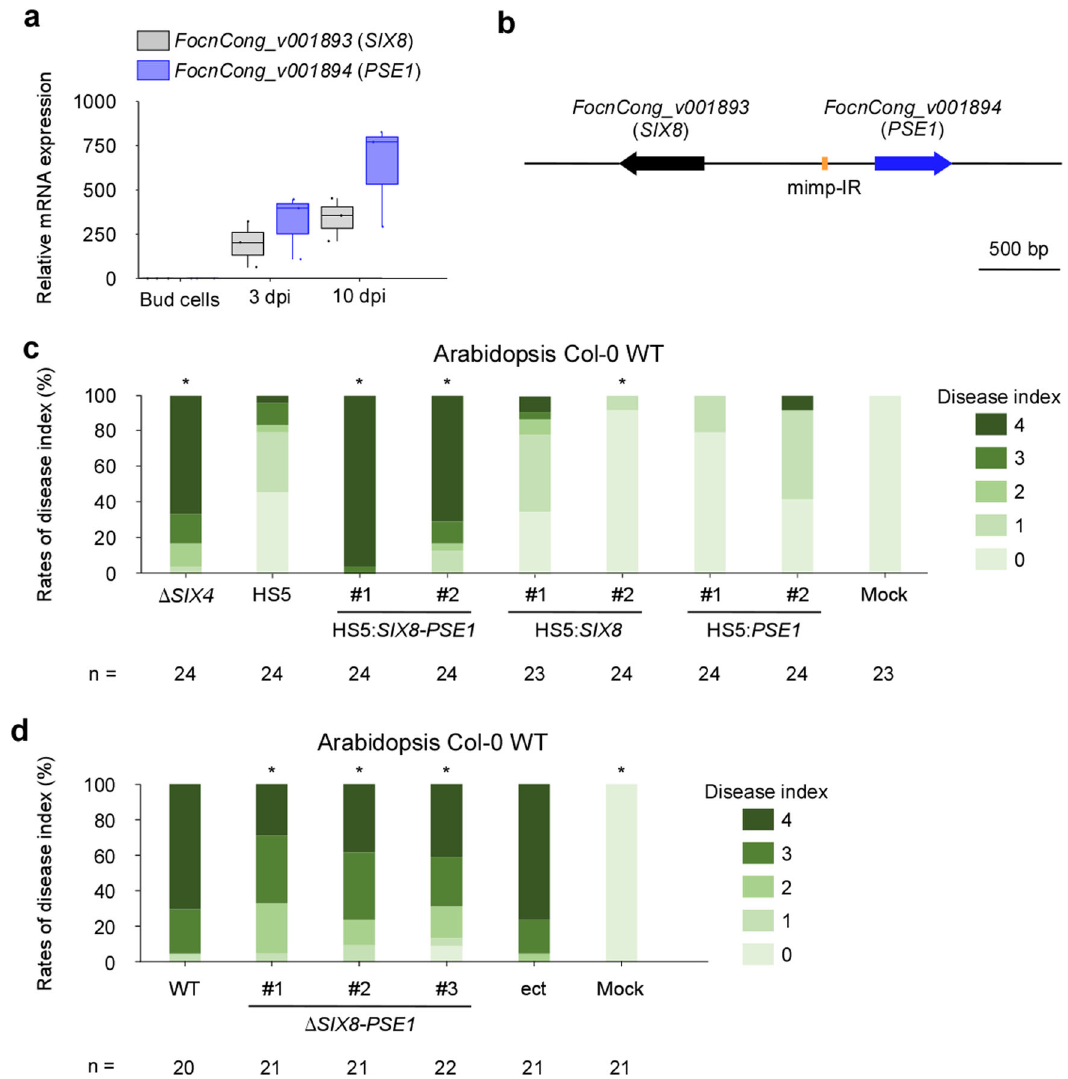
Fig. 5 The SIX8 - PSE1 locus is involved in virulence of Focn Cong:1-1 on Arabidopsis. a Relative transcript levels of FocnCong_v001893 ( SIX8 ) and FocnCong_v001894 ( PSE1 ) during infection of Arabidopsis Col-0 WT at 3 and 10 dpi. Data from three biologically independent samples are presented as fold changes compared with expression levels in bud cells. Expression levels were determined by qRT-PCR and normalized against Focn Cong:1-1 β -tubulin ( TUB2 ). Boxplots indicate median value, estimated 25th and 75th percentiles, and whiskers represent 1.5 times the interquartile range. b Schematic representation of the SIX8 - PSE1 locus in Focn Cong:1-1. mimp-IR miniature impala-like inverted repeat. c Virulence of Focn Cong:1-1 Δ SIX4 , HS5, and